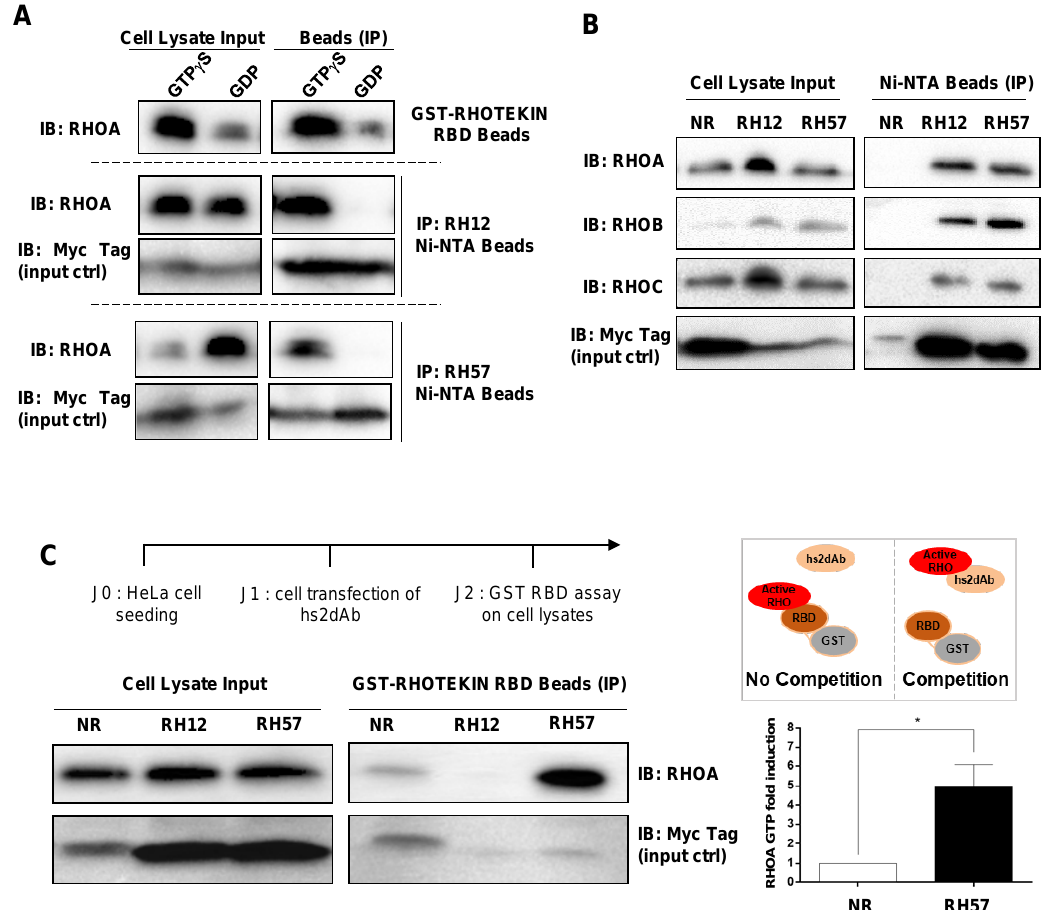
Figure 3. Intracellular antibody characterization of RH57 hs2dAb. ( A ) The hs2dabs RH12 and RH57 were expressed in HeLa cells with a 6xhis and carboxy Myc tag and the endogenous RHO GTPases were loaded with either GTP γ S or GDP in the cell lysate. The intracellular antibodies were immuno-precipitated with Capture Select His tag affinity beads and an anti-RHOA antibody was used to monitor which pool of RHO (GTP or GDP) was bound by the intracellular antibodies. The recovered intracellular antibodies were monitored by immuno-blotting with anti-Myc tag. The GST-RHOTEKIN RHO binding domain (RBD), which allows to pull down GTP-bound RHO proteins on glutathione beads, was used as positive control. ( B ) Intracellular antibody immuno-precipitation assays on endogenous RHO proteins. Assays were performed as in panel A, but on non-loaded endogenous RHO proteins. The non-related NR hs2dAb was used as a negative control. (C) GST-RHOTEKIN RBD interference assay intracellular antibodies. The hs2dabs NR, RH12, and RH57 were expressed in HeLa cells with a 6xHis and carboxy Myc-tag. Intracellular expression of RH12 impedes the GST-RBD capture of RHOA-GTP. RH57 induced an increase of RHOA-GTP. NR binds to the beads. Representative blot of three independent experiments. Right: scheme of the binding competition events. Quantification of RHOA-GTP fold increase in RH57 conditions compared with the NR condition reveals potential stabilization of RHOA-GTP or GAP inhibition activity by the RH57. Error bars are mean ± SD of the biological repeats. * p < 0.05. IP = immuno-precipitation; IB =